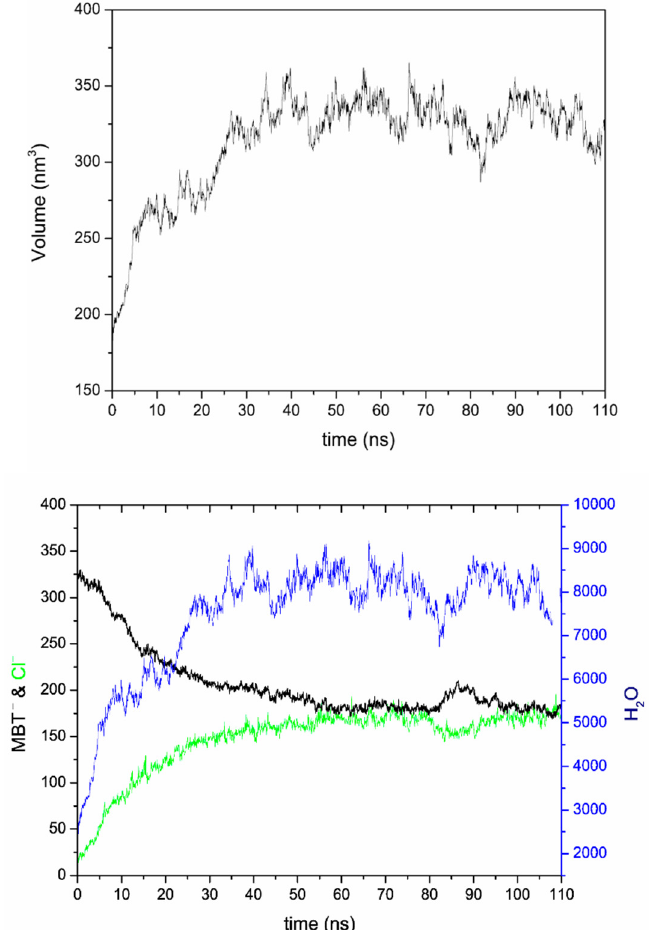
Figure 5. Volume (in nm 3 ) described by the metal atoms (Al and Zn) position corresponding to the cationic layers of the LDH-MBT model particle in each frame of the MD simulation (top). The color of the molecular species inside the LDH-MBT interlayers is black for 2-mercaptobenzotiazole in the anionic form (MBT − ), green for chloride anions, and blue for water molecules (bottom).